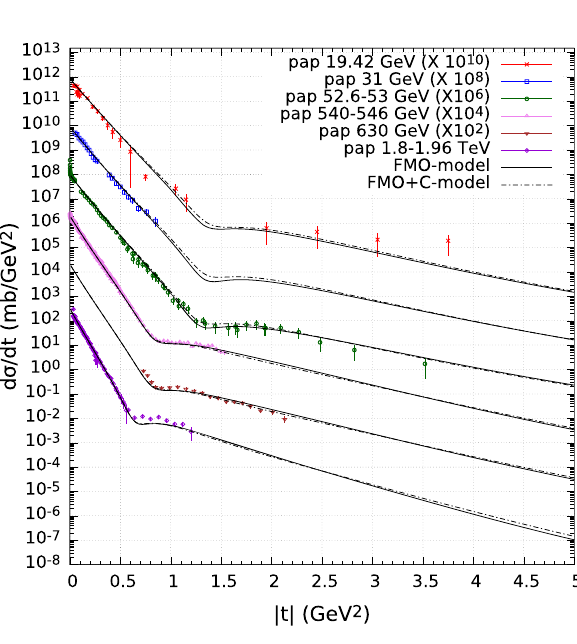
¯ pp differential cross sections at